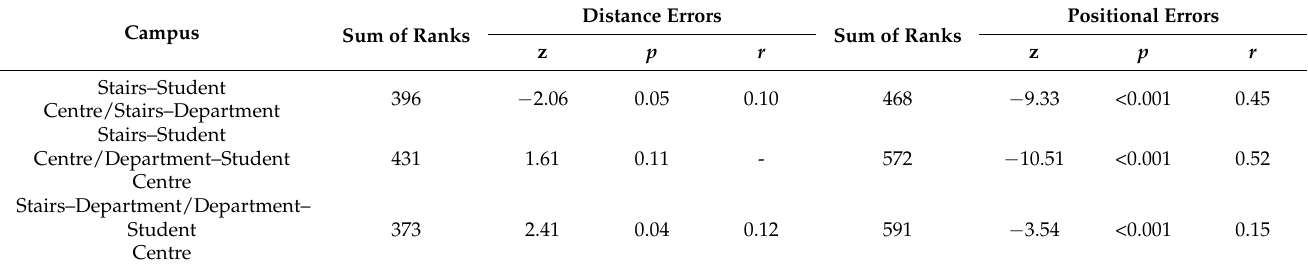
Table 6. For distance errors and positional errors of the campus area, the sum of ranks, n , z score, the p -value, p , and Cohen’s r of the Wilcoxon matched pairs test were